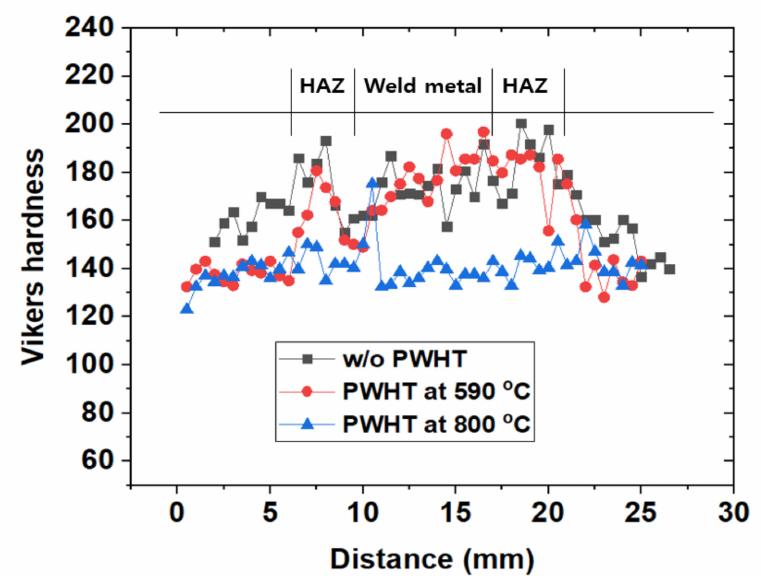
Figure 11. Micro hardness distribution.